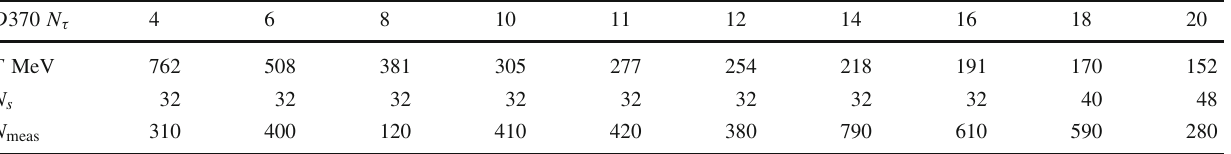
Table 2 Grid sizes and temperatures in the D370 ensembles used for the computation of the correlation functions below. N meas refers to the number of available correlator